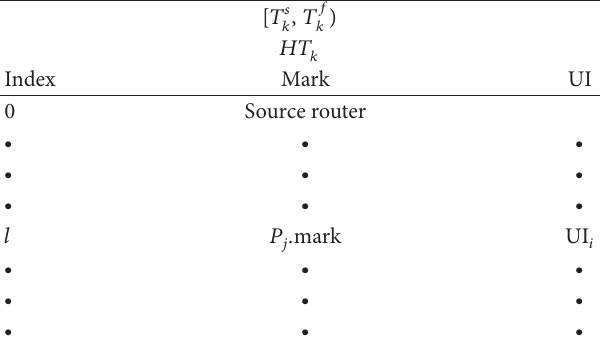
Table 2: Log table 𝐻𝑇 𝑘 created at 𝑇 𝑠 𝑘 , full at 𝑇